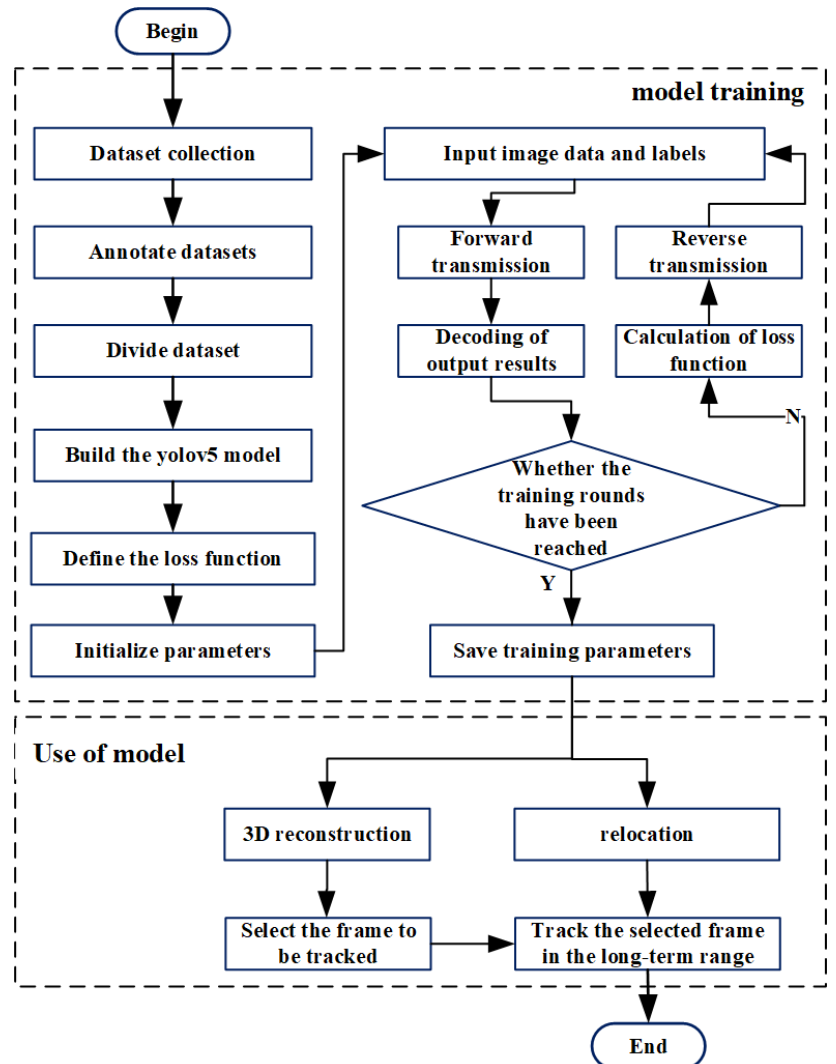
Figure 2. Flow chart of model training.